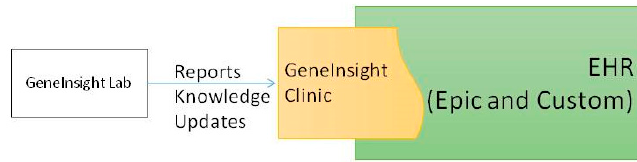
Figure 2. Clinician facing infrastructure.